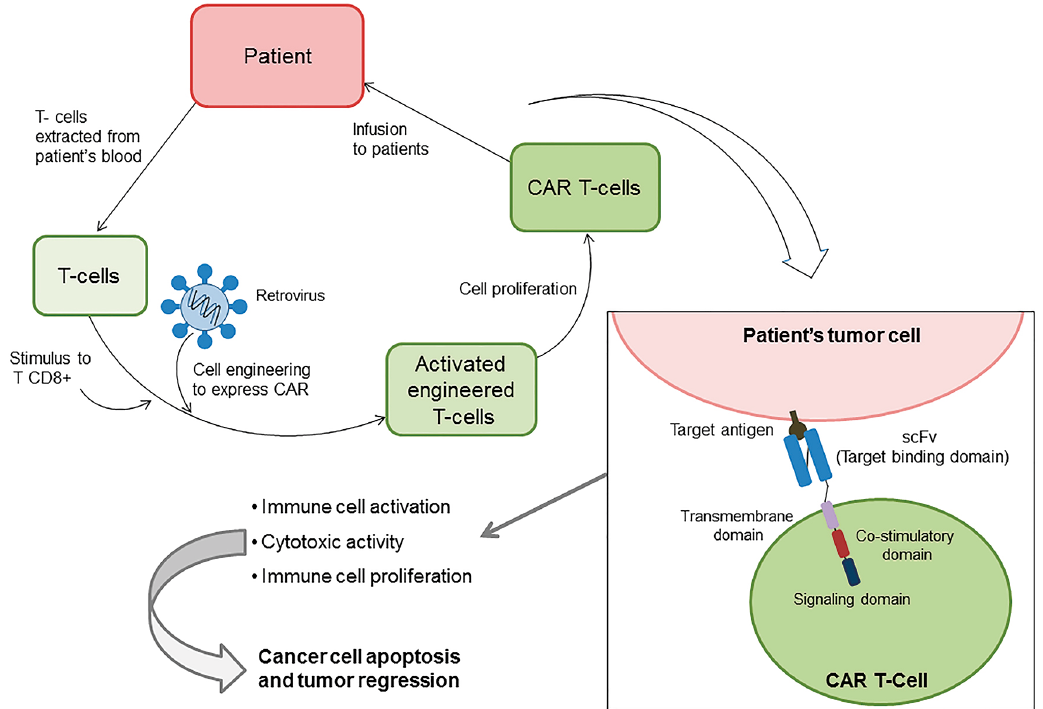
FIGURE 4 – CAR-T cell therapy. The patient’s immune cells are first collected from the bloodstream by leukapheresis. In vitro , these cells are stimulated to express CD8 receptor and engineered by infection with a retrovirus containing genes of the chimeric antigen receptor which will be expressed by the TCD8+ cell – this CAR is basically a scFv against the tumor cell target linked to a transmembrane domain, a co-stimulatory domain (which enhances the immune response) and a signaling domain (responsible by the activation of the T cell) in tandem. The T cells are then expanded over 7-10 days and delivered back to the patient by intravenous infusion. Their bind to the tumor cell elicits the immune response leading to tumor